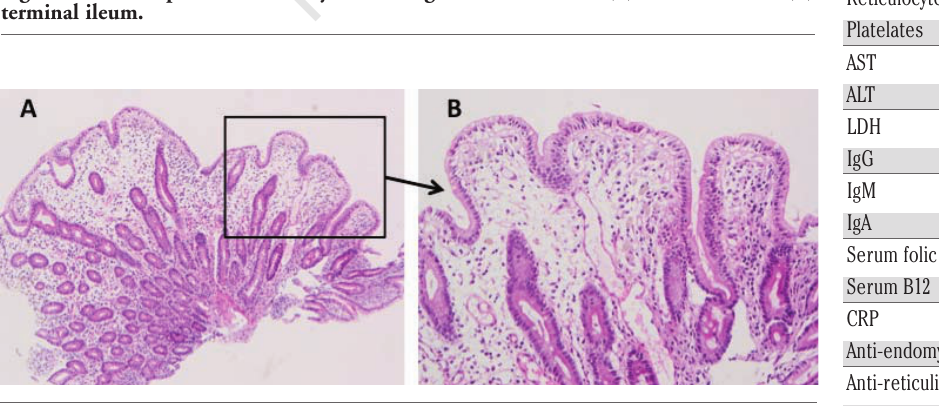
Figure 2. Histologic examination of specimens from the duodenum taken during initial upper endoscopy: A) villous atrophy and planarized mucosa is seen (Haematoxylin and Eosin staining used, original magnification 4x); B) lymphocytic and inflammatory cell infiltration are seen (Haematoxylin and Eosin staining, original magnification